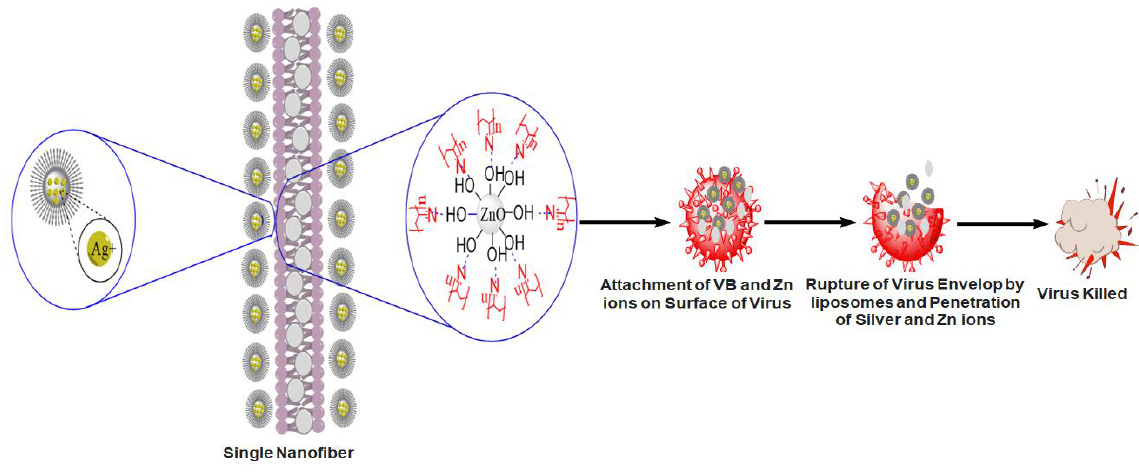
Figure 8. Schematic representation of antiviral activity of VB-loaded PAN/ZnO electrospun nano- fibers.